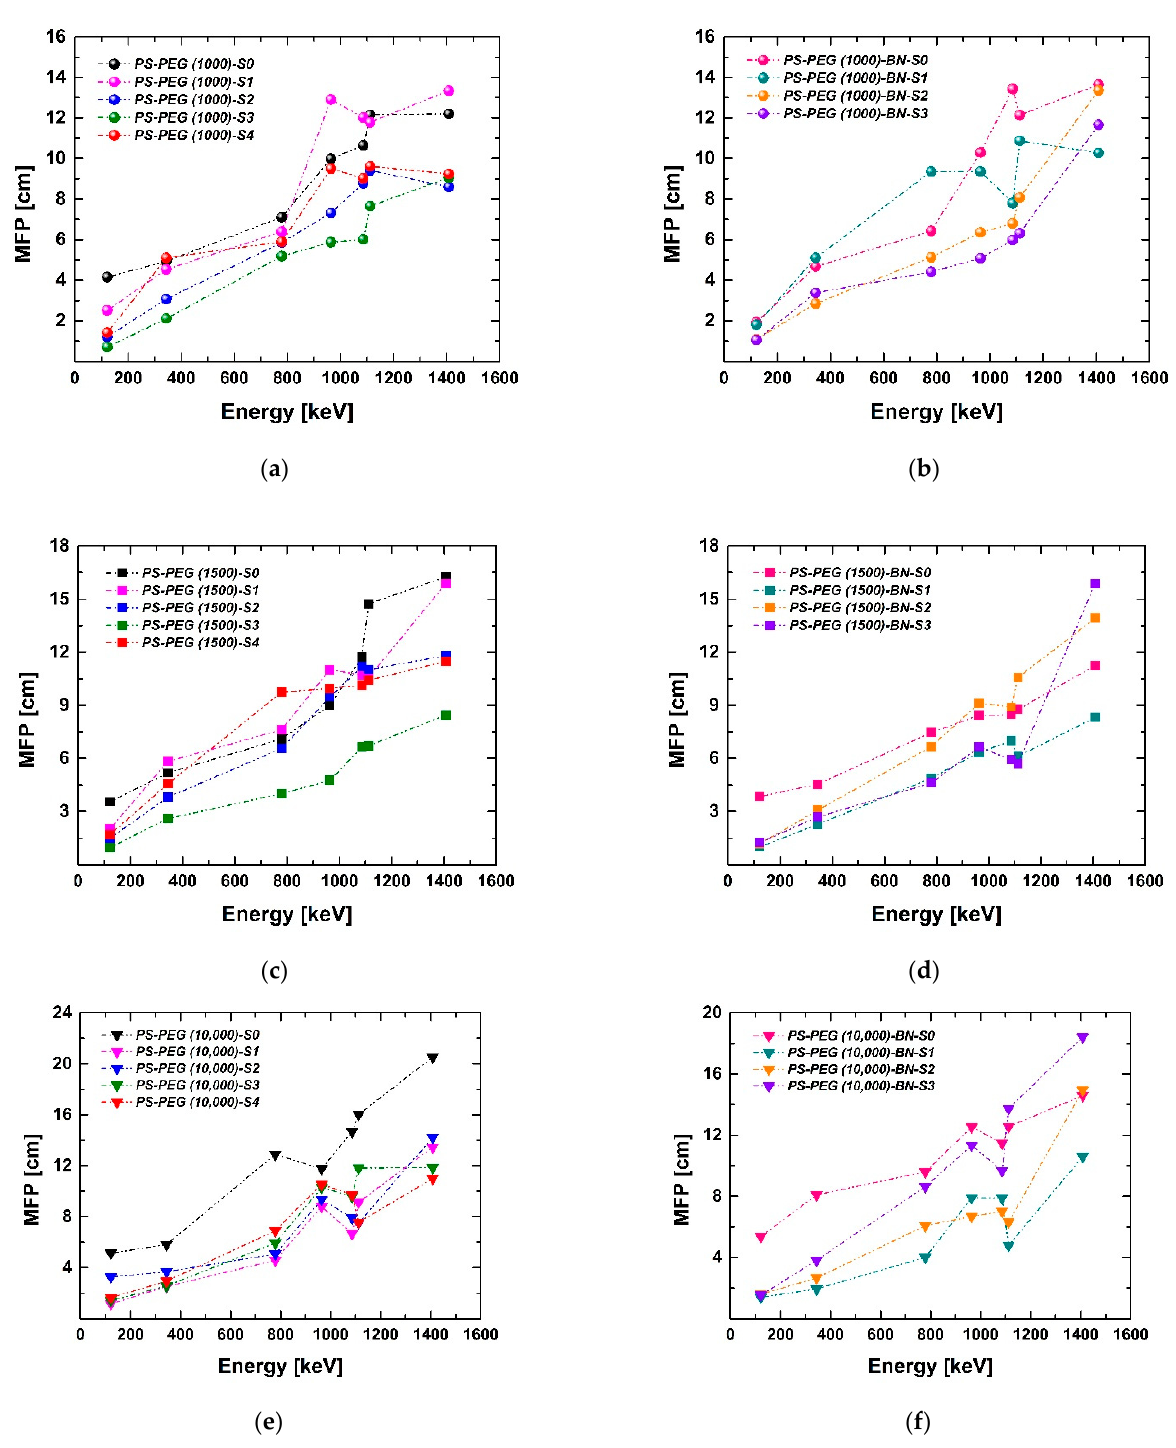
Figure 10. The MFP values of the PbO doped the crosslinked PS-b-PEG block copolymers and the PbO doped the PS-b-PEG-BN nanocomposite materials at different gamma radiation energies (from 121.782 keV to 1408.006 keV) of 152 Eu : ( a ) PS-PEG (1000)-S0,S1,S2,S3,S4; ( b ) PS-PEG (1000)-BN-S0,S1,S2,S3; ( c ) PS-PEG (1500)-S0,S1,S2,S3,S4; ( d ) PS-PEG (1500)-BN-